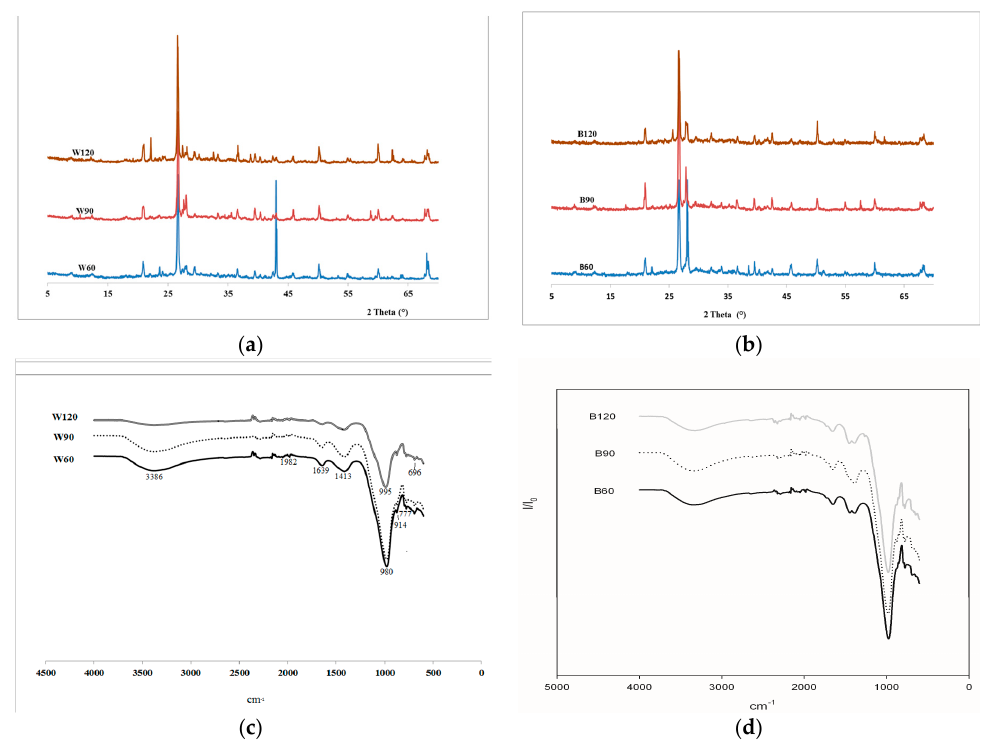
Figure 3. XRD and FT-IR characterization of the white and black slag-based AAS mortars: ( a ) XRD of white; and ( b ) black ABS; ( c ) FT-IR of white; and ( d ) black ABS.